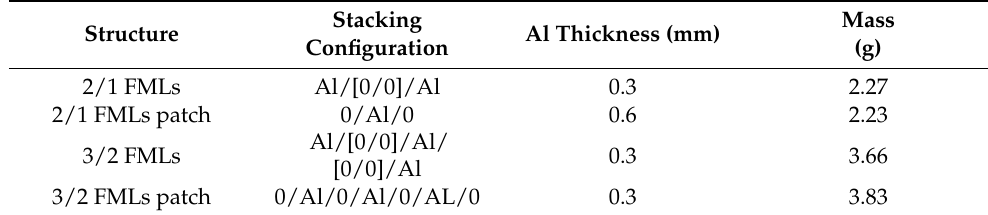
Figure 2. The detailed stacking configurations of thermoplastic fiber metal hybrid laminates. Table 3. The abbreviation and stacking configuration of FMLs